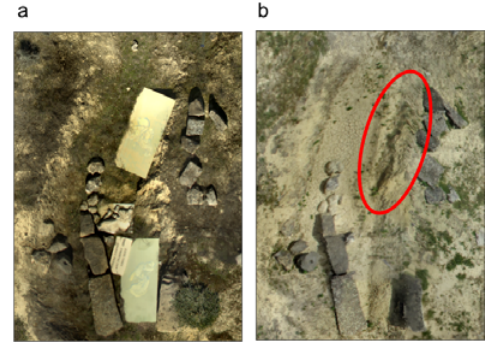
Figure 8. Detailed of zones with ghost and stretched images into CP orthoimage: a) NCP case; b) CP